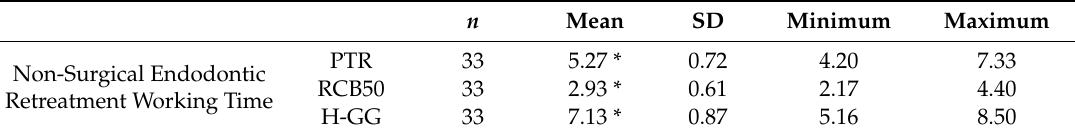
Table 3. Descriptive analysis of non-surgical endodontic retreatment working time (min) regarding the non-surgical endodontic retreatment study